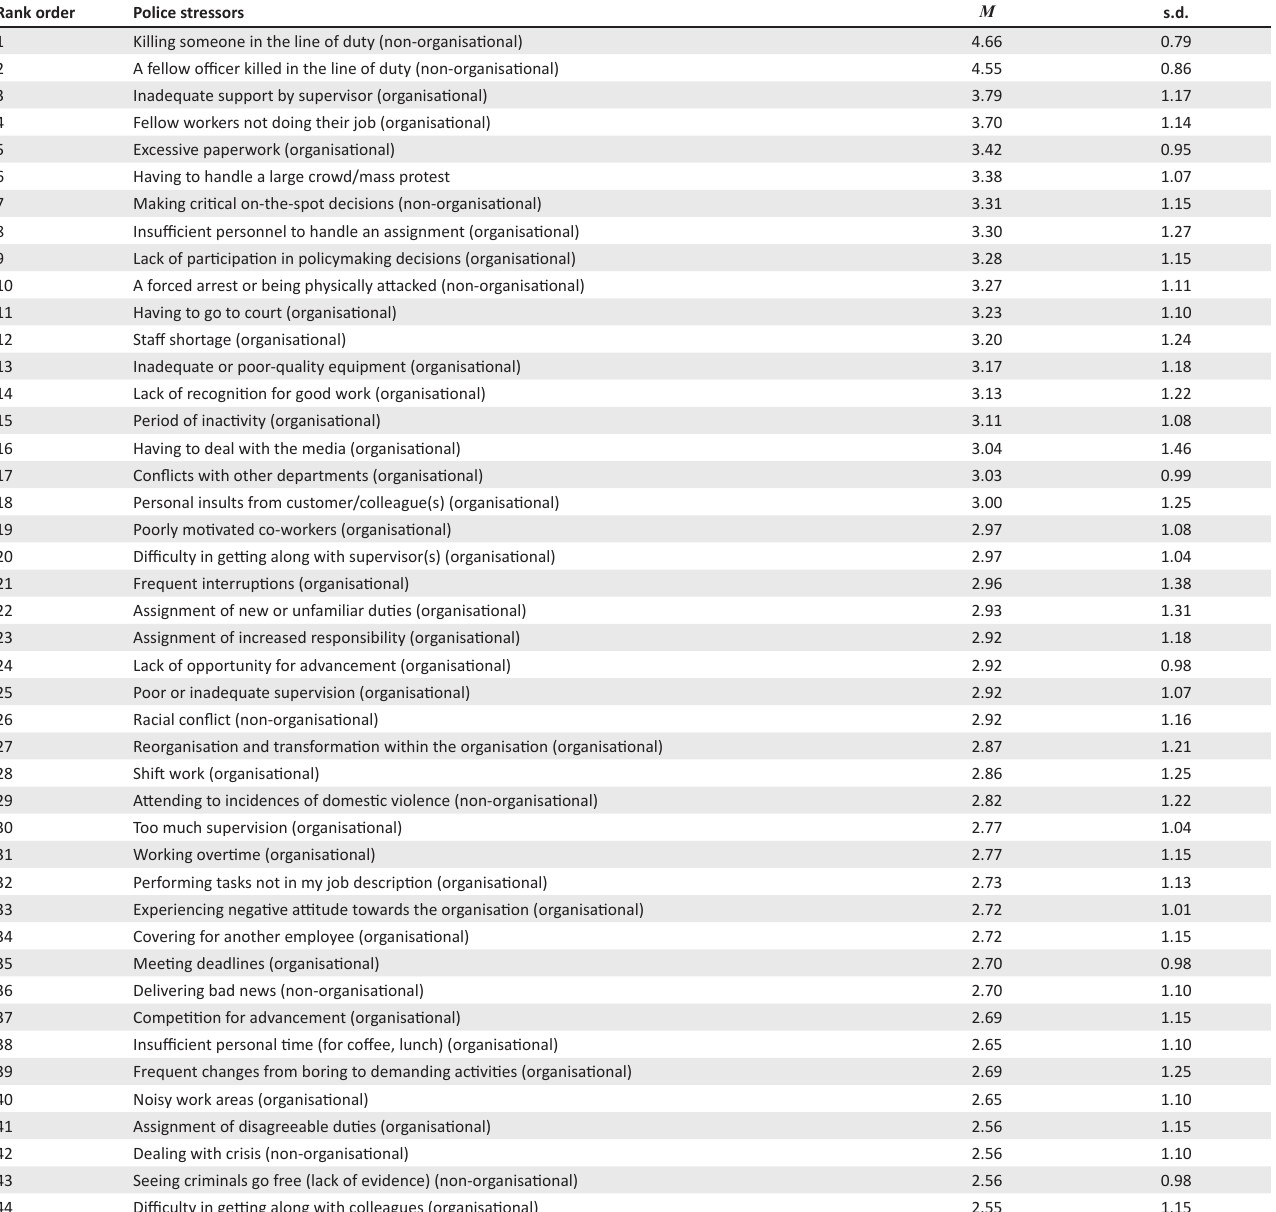
TABLE 4: Police stressors in rank order (organisational and non-organisational). Rank order Police